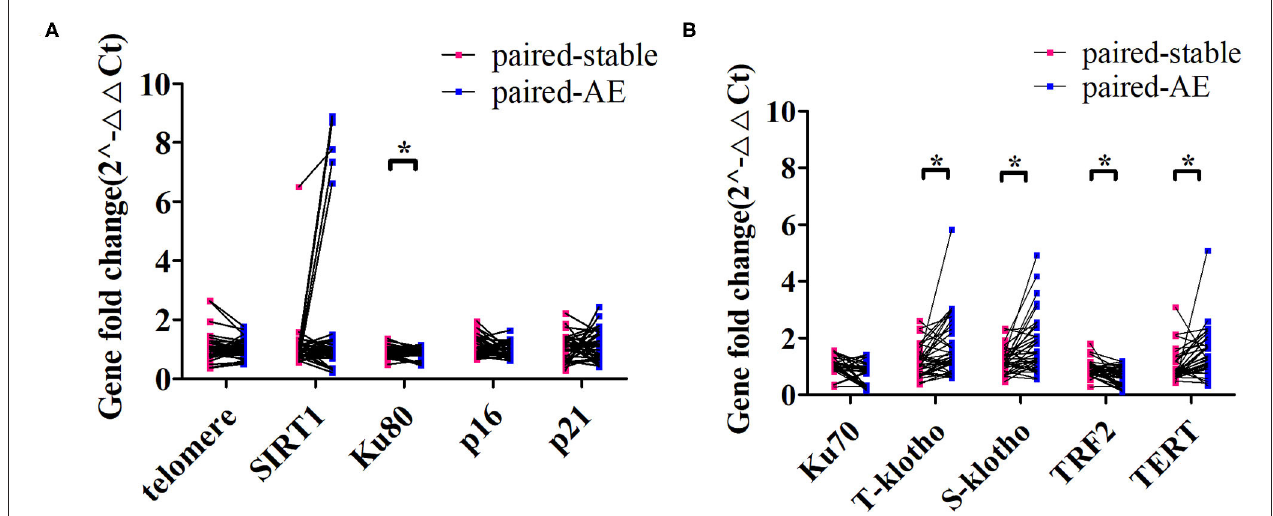
FIGURE 4 | Changes in the expression levels of aging markers from clinically stable to the onset of exacerbation among patients with bronchiectasis. (A) demonstrates the comparison of the expression levels of the relative telomere length (telomere), SIRT1, Ku80, p16, and p21 for the paired clinically stable and exacerbation visit samples. (B) displays the comparison of the expression levels of Ku70, total klotho (t-klotho), soluble klotho (s-klotho), telomeric repeat-binding factor 2 (TRF2), and telomerase reverse transcriptase (TERT) for the paired clinically stable and exacerbation visit samples. *Denotes the comparisons with statistical significance ( p <